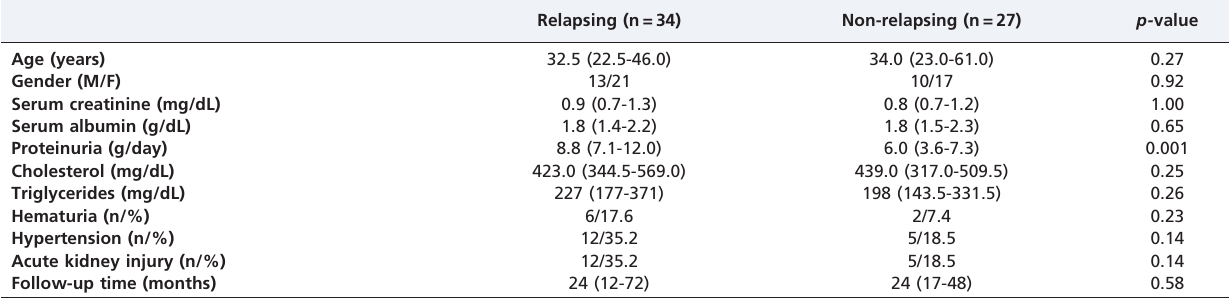
Table 1 - Clinical characteristics of relapsing and non-relapsing patients at